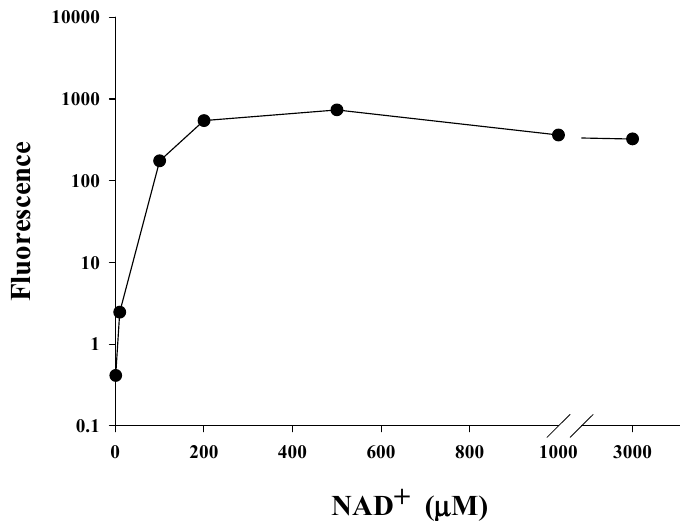
Figure 5. SIRT1-saturating NAD + concentration in vitro. SIRT1 activities were determined in reactions containing various concentrations of NAD + (1, 10, 200, 500, 1000, and 3000 µ M NAD + , n = 3 independent experiments) using a commercialized SIRT1 Fluorescence Resonance Energy Transfer (FRET)-based screening assay kit.